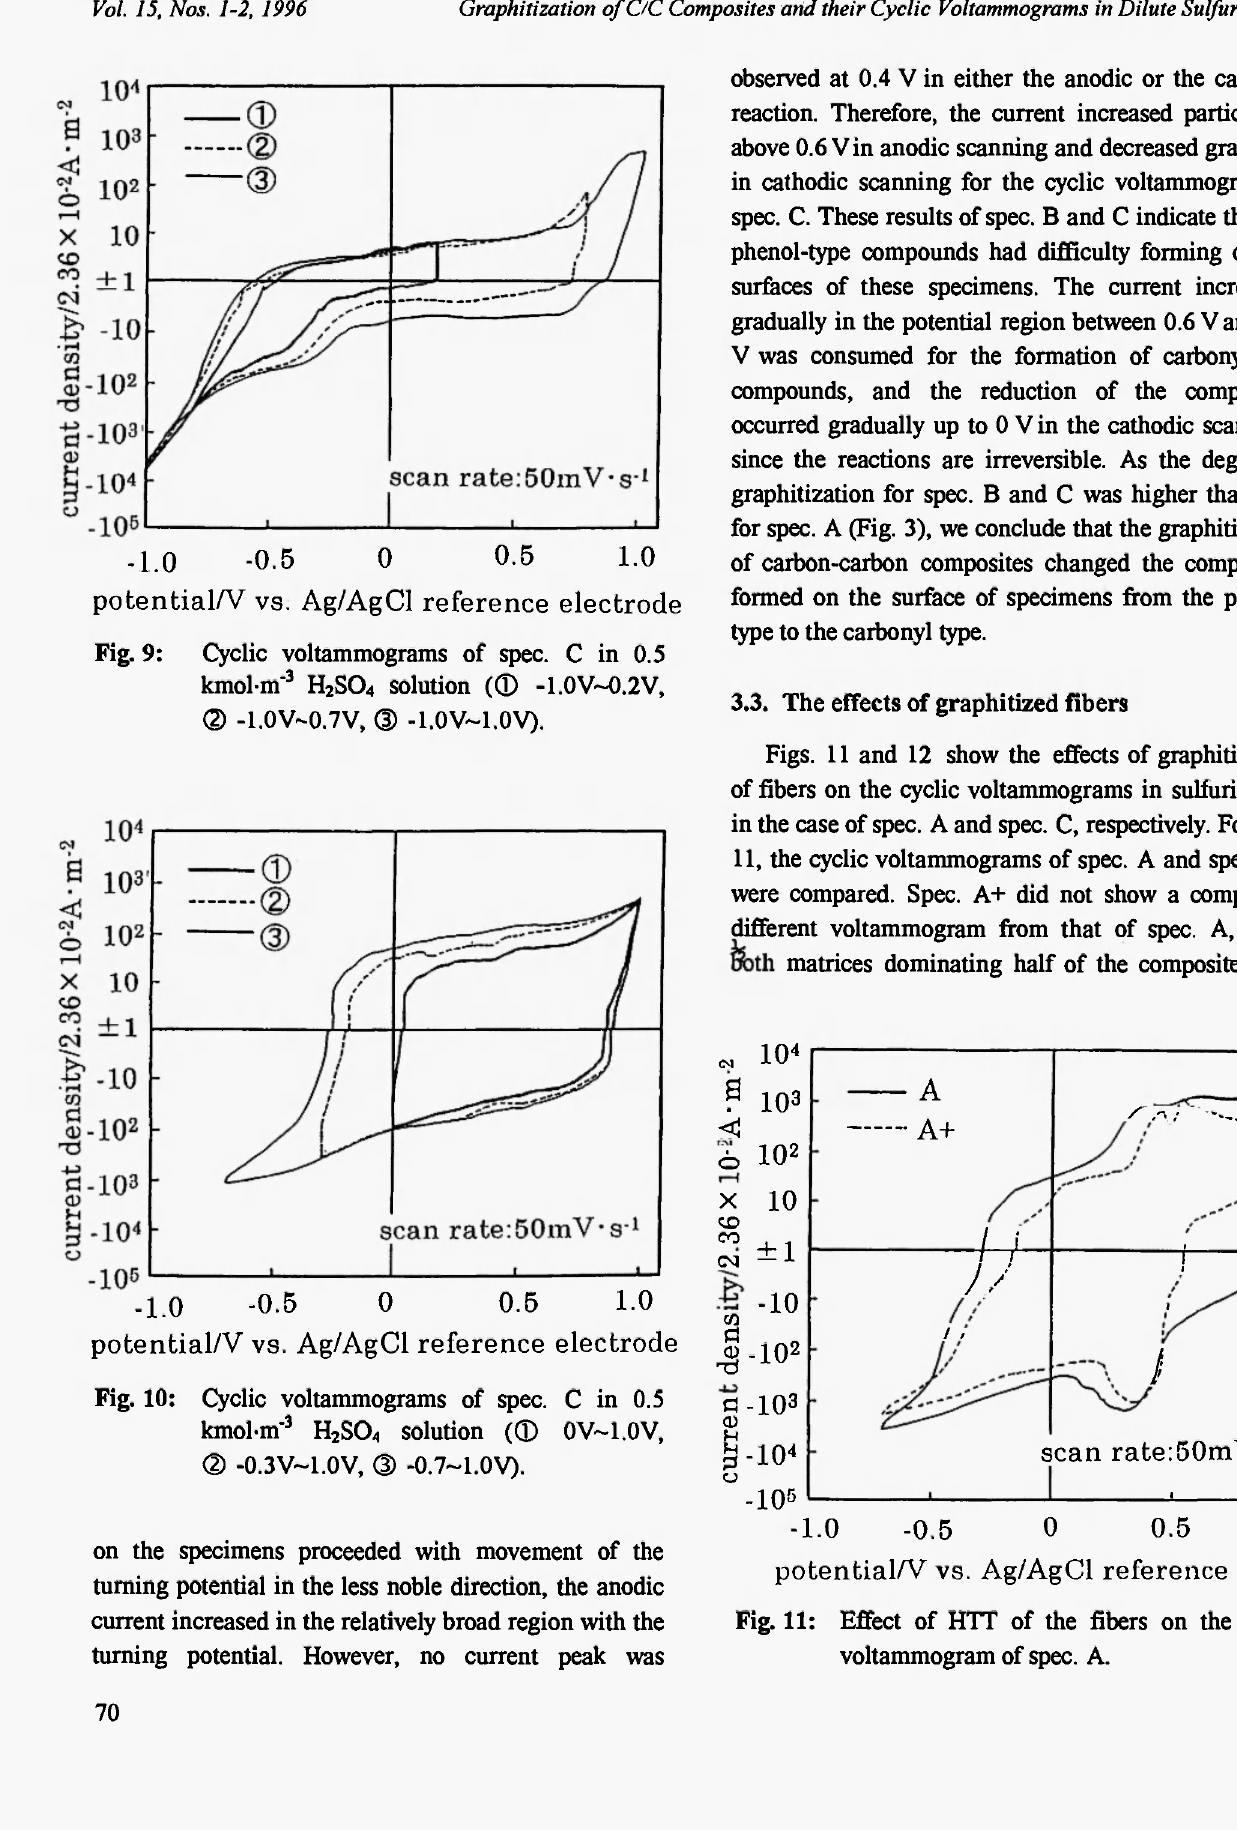
Fig. 11: Effect of HTT of the fibers on the cyclic voltammogram of spec.